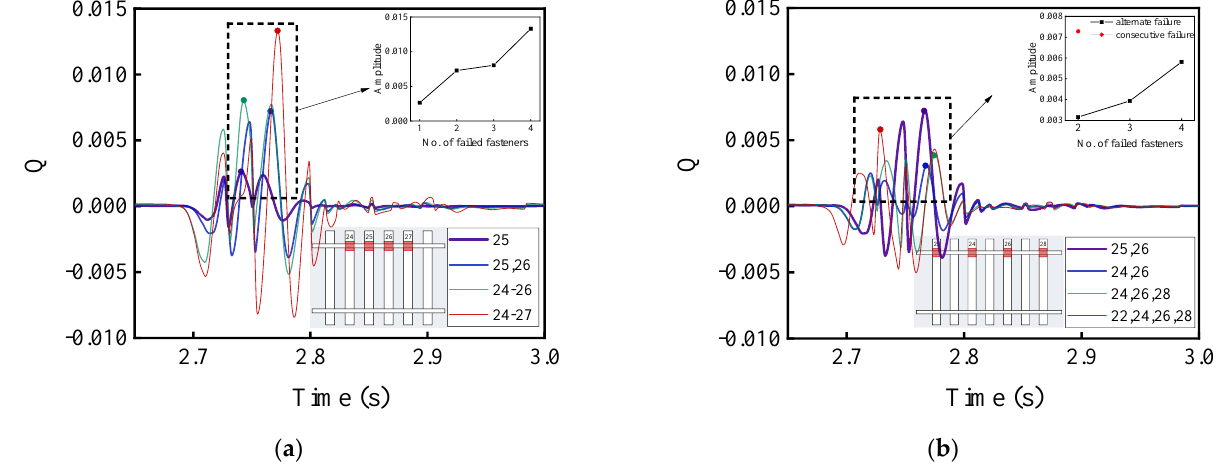
Figure 18. Model-calculated time-history variations of the wheel load reduction rate with ( a ) single-side consecutive and ( b ) single-side alternate fastener failures.